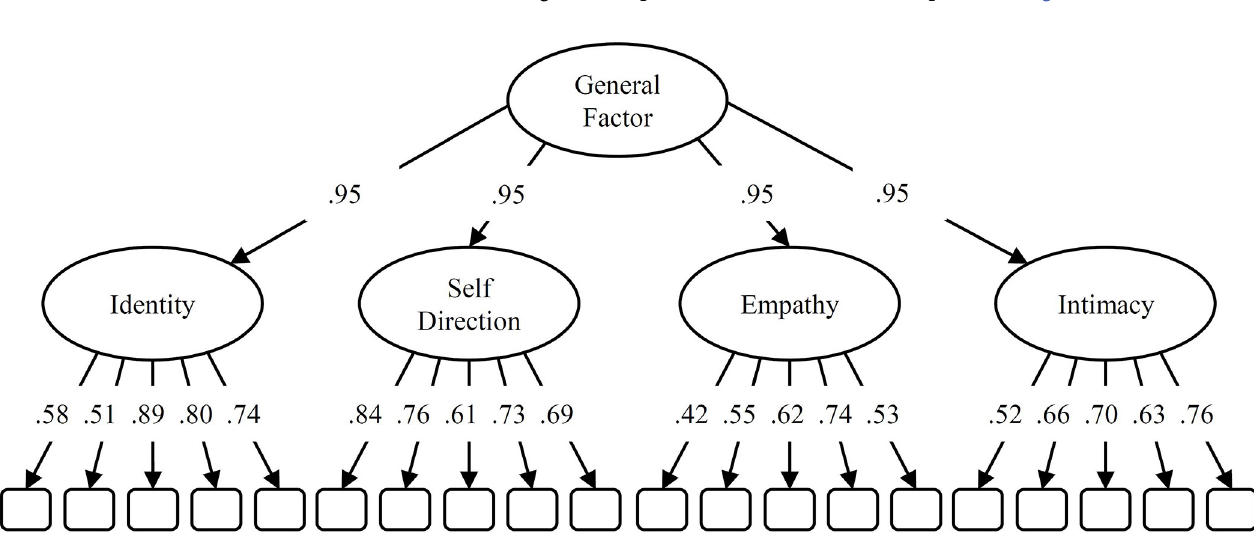
Fig 2. Factor loadings of short version. Optimized model using ant colony optimization to develop a short version to identify personality disorders in adolescence. The configuration corresponds to model 7b in Fig